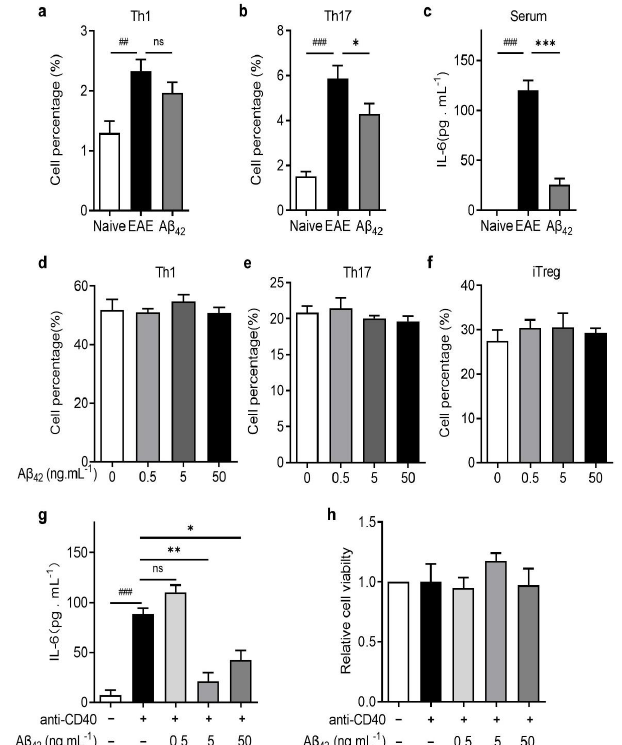
Figure 4. A β 42 reduced IL-6 production and inhibited Th17 development in vivo. ( a , b ) Th1 and Th17 cells were analyzed in vivo. ( c ) The levels of IL-6 in serum of naïve mice, EAE mice, and A β -treated EAE mice were measured in vivo. ( d – f ) Naive CD4+ T cells isolated from C57BL/6J mice were induced to differentiate into Th1, Th17, and iTreg cells with the addition of different concentrations of Aβ42 (0.5, 5, or 50 ng/mL) in vitro. ( g , h ) The IL-6 level and the relative viability of dendritic cells were measured by ELISA in vitro. Data are presented as mean ± SEM, *** p < 0.001, ** p < 0.01, * p < 0.05, ### p < 0.001, ## p < 0.01, ns: not significant ( n = 3 –5, Student’s t -test).